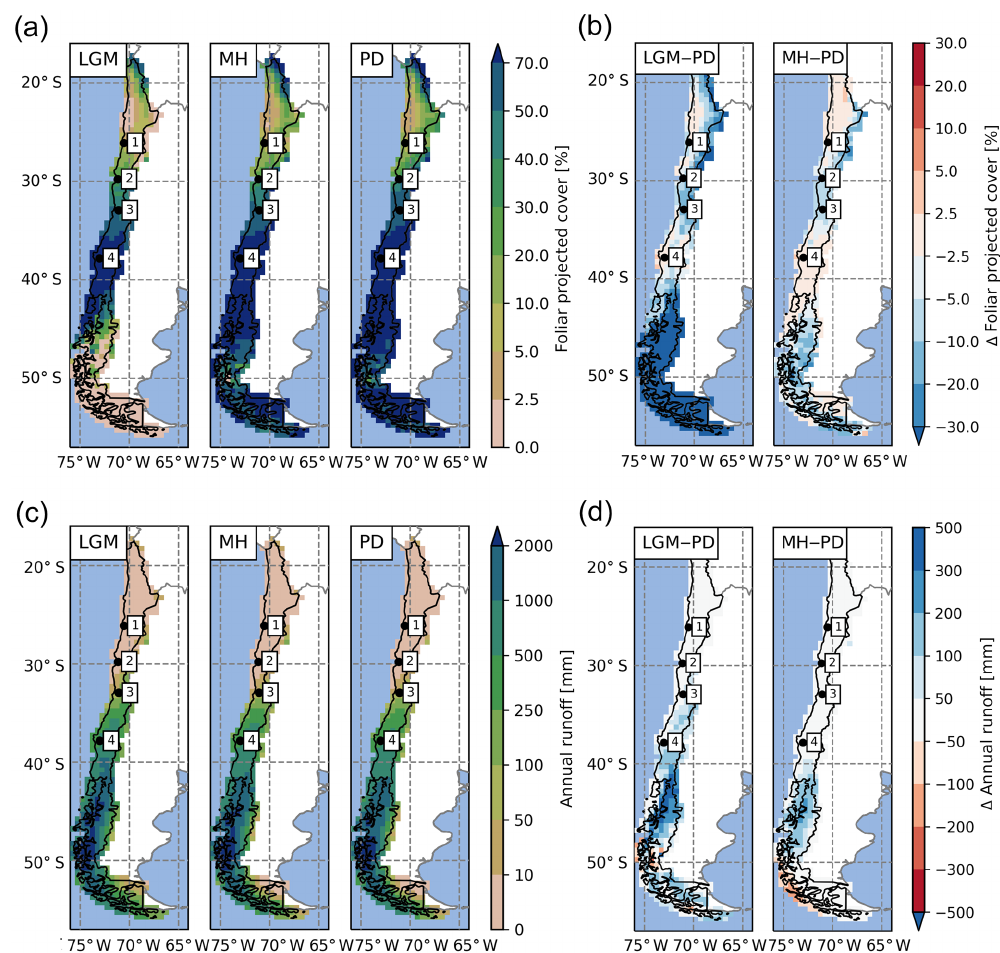
Figure 6. Spatial distribution of (a) foliar projected cover and (c) surface runoff simulated for the Last Glacial Maximum (LGM), the mid- Holocene (MH), and the present day (PD). Difference plots of LGM versus PD (left) and MH versus PD (right) for foliar projected cover (b) and runoff (d) , respectively (the number 1 represents Pan de Azúcar, 2 represents Sta. Gracia, 3 represents La Campana, and 4 represents